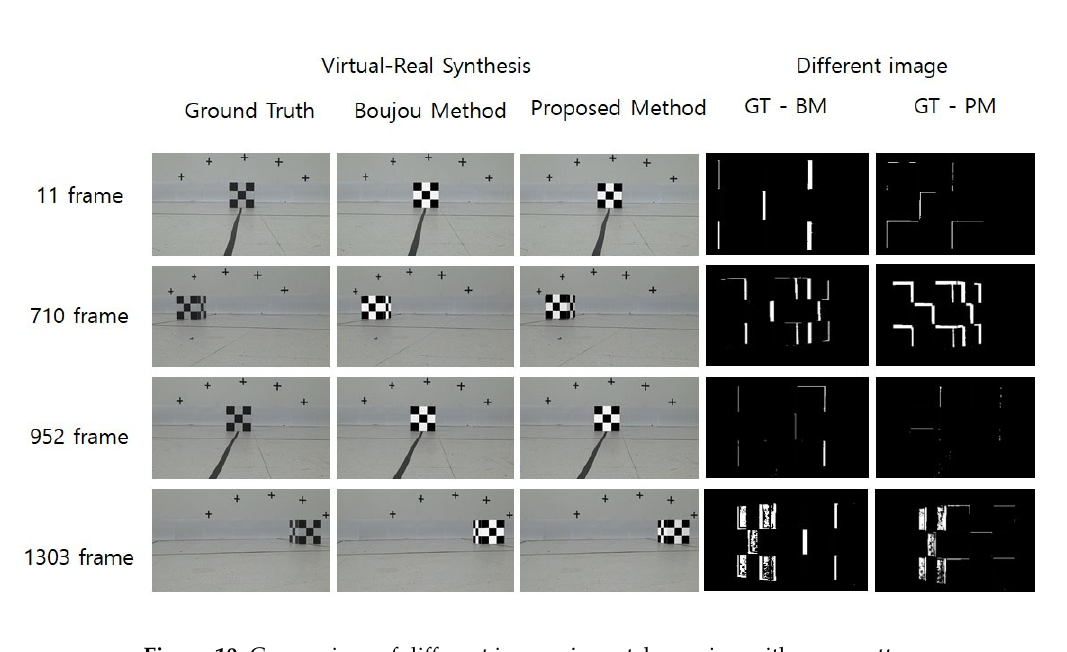
Figure 10. Comparison of different images in match-moving with cross pattern.